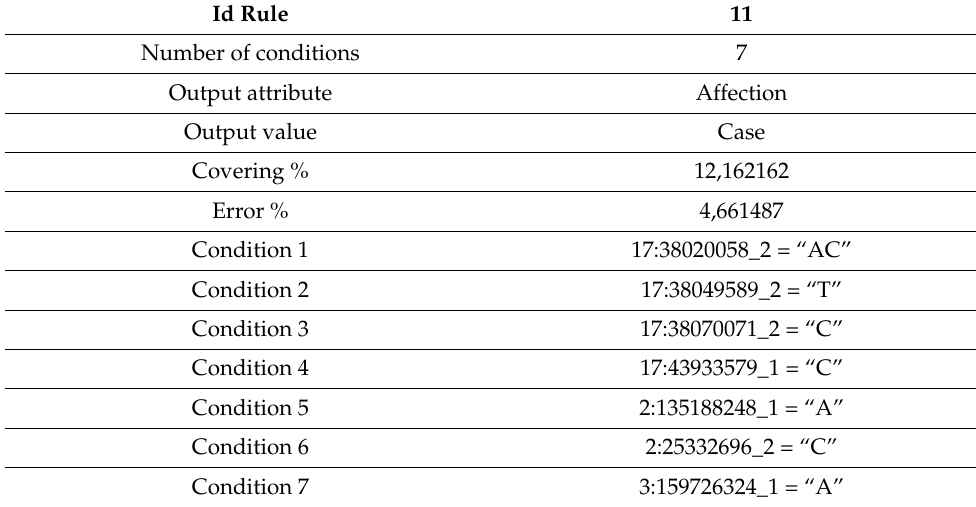
Table 3. Best rule for prediction using only genetic